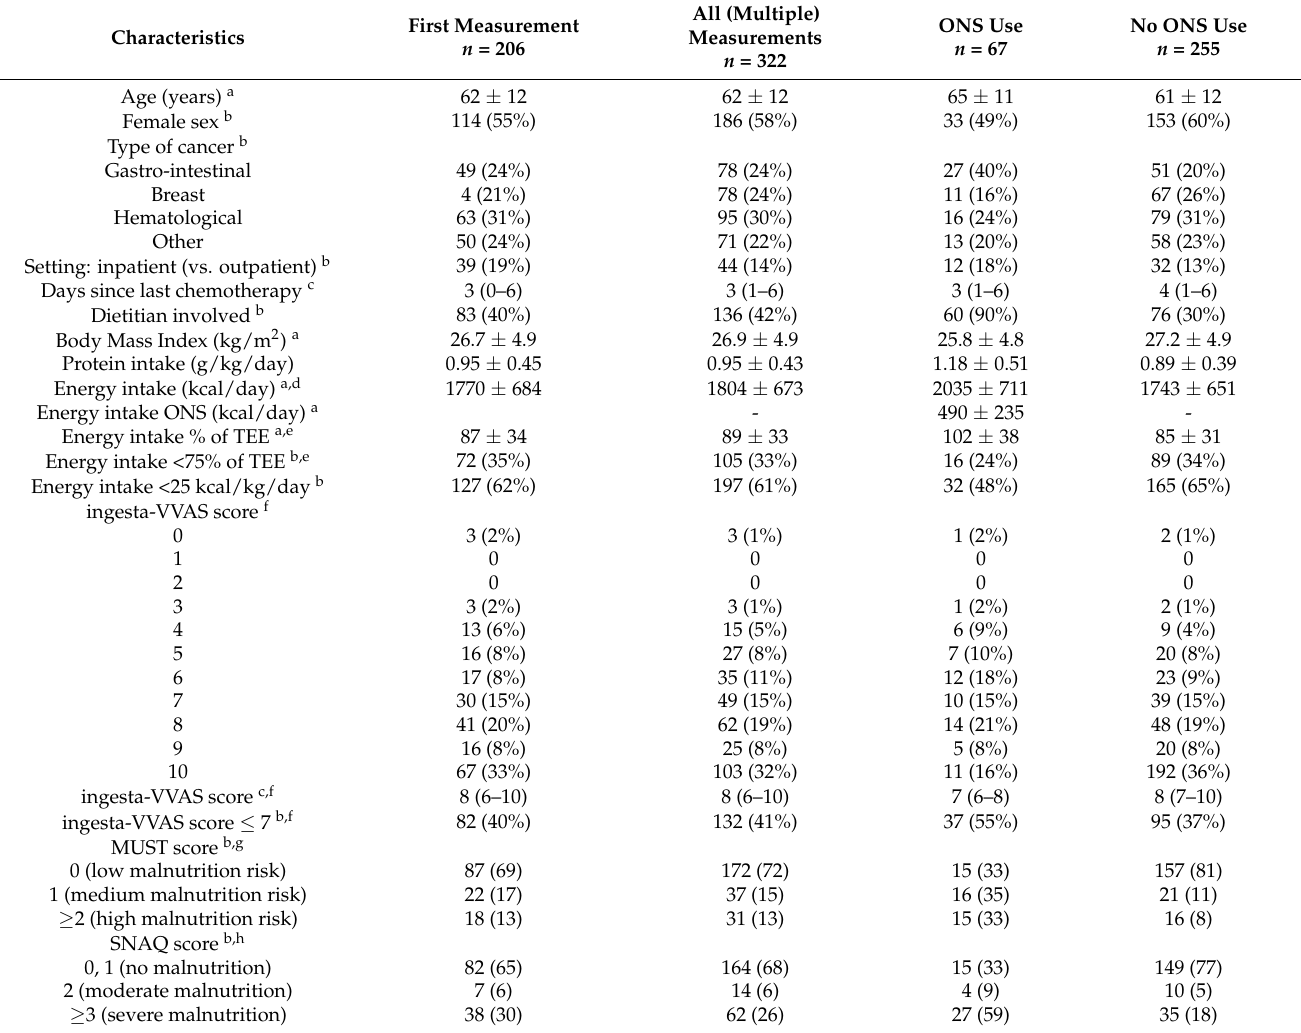
Table 1. Characteristics of the included oncology patients undergoing chemotherapy, stratified by oral nutritional supplement (ONS)